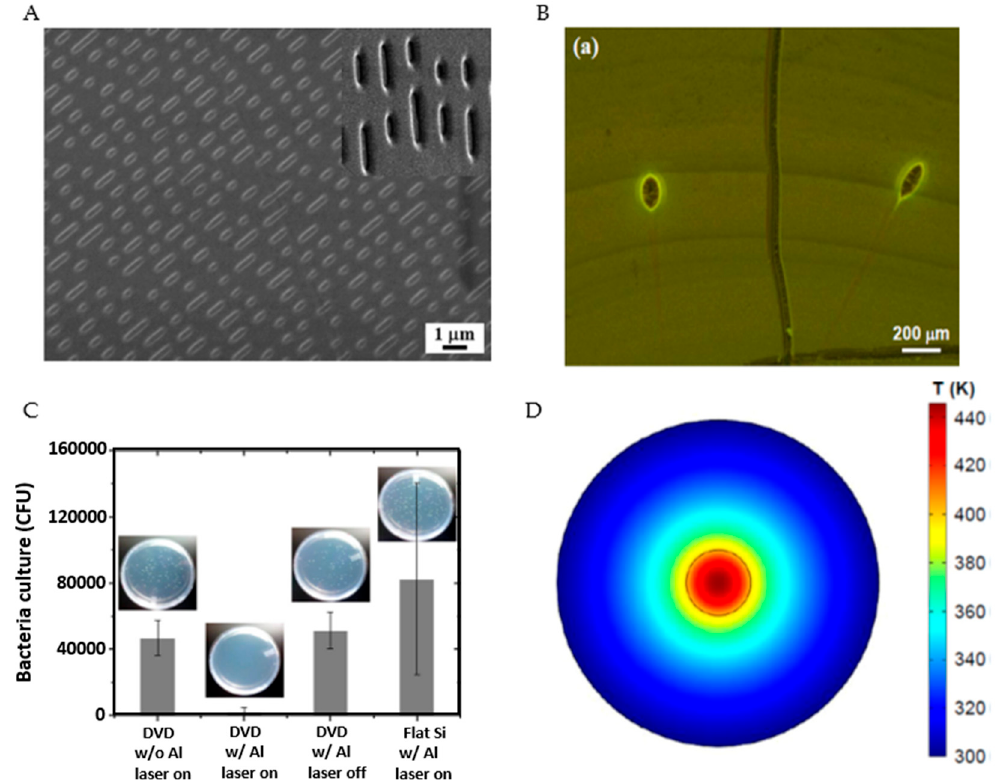
Figure 6. ( A ) Scanning electron microscopy (SEM) image of Al plasmonic substrate made of an inexpensive commercial DVD of a King Kong, 2005 movie, showing patterned rod-shaped Al nanostructures. Inset shows a magnified part of the substrate. ( B ) Fluorescence image of two 785 nm laser-illuminated spots in GFP tagged E. coli -covered DVD, showing laser-induced thermal damage. ( C ) Photograph of bacterial cultures and counts in colony-forming units (CFU) of E. coli on DVD and flat Al-covered Si showing e ffi cient bacterial inactivation due to Al plasmonic treatment. ( D ) Simulated distribution of temperature of a 2 mm diameter DVD piece illuminated by a 400 µ m diameter laser spot, showing high temperature T > 400 K, enough to inactivate bacteria. (Adapted from Dou et al. [208]).